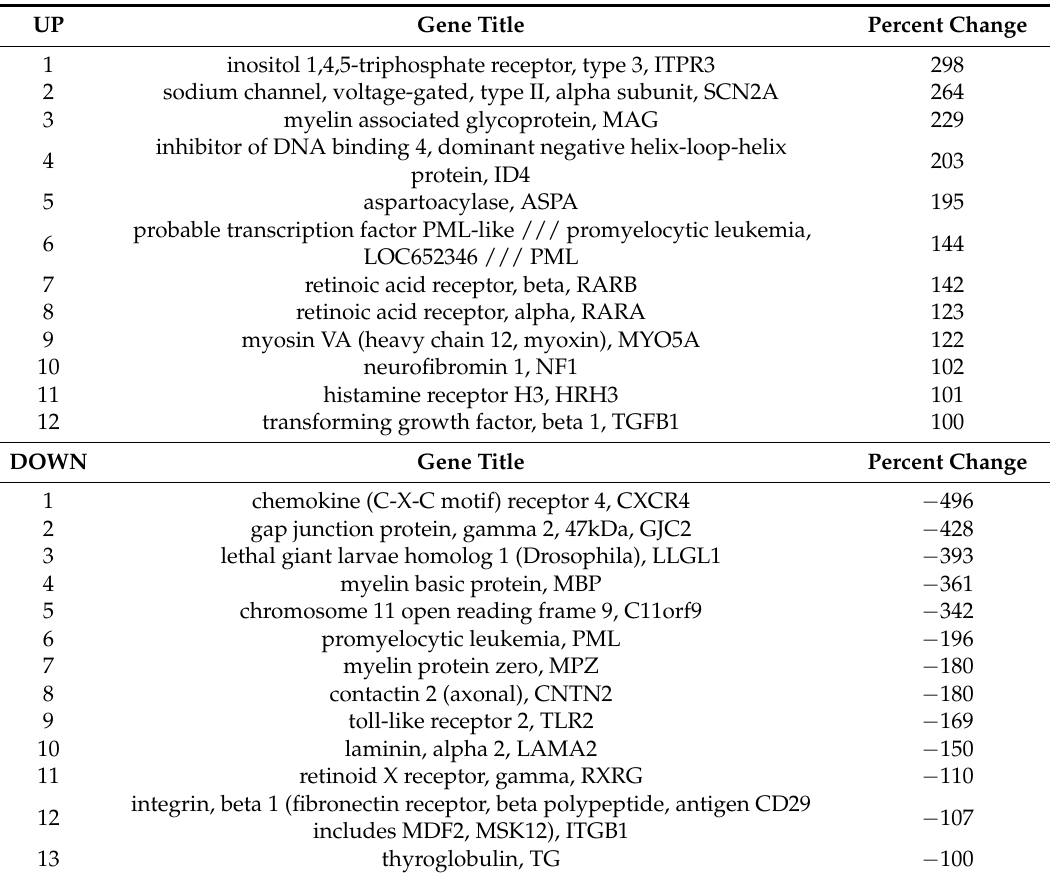
Table 22. GHK and Genes Associated with